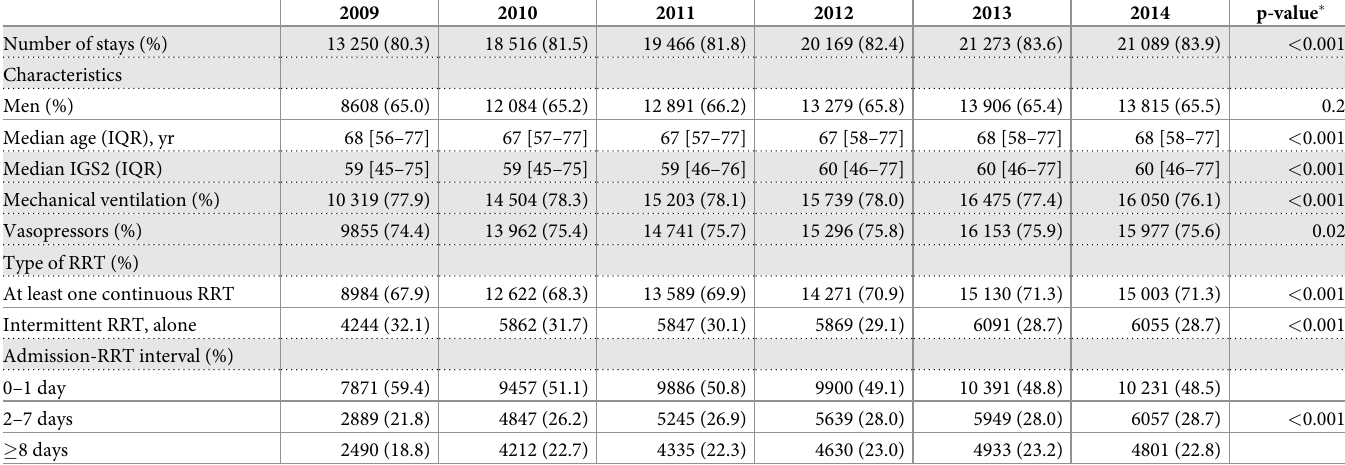
Table 3. Changing patterns in patient characteristics and management of stays with AKI requiring dialysis in intensive care units between 2009 and 2014 in metro- politan